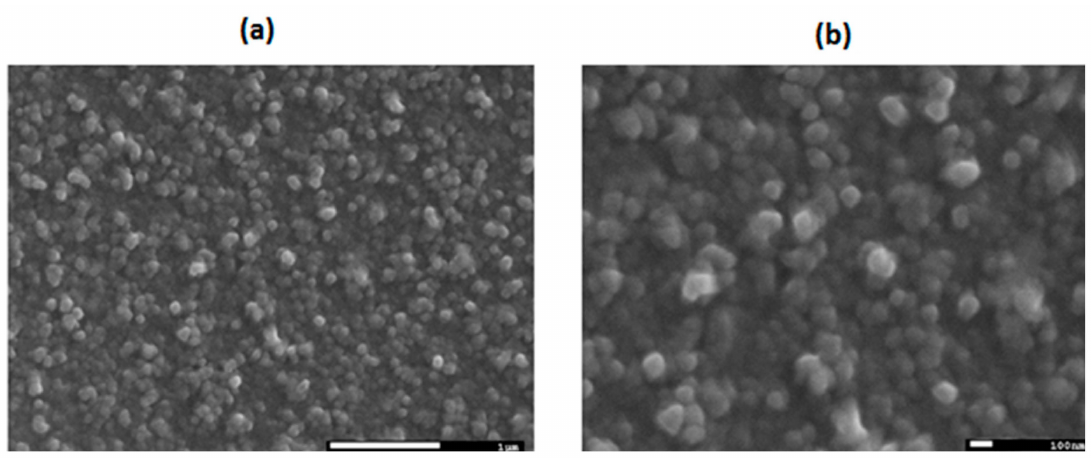
Figure 2. SEM images of TTF deriv -CuPc thin films deposited onto silicon wafers, at amplification ( a ) 25,000 ˆ and ( b ) 50,000 ˆ .